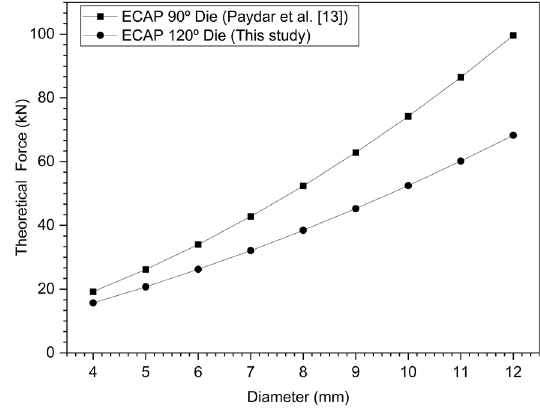
Figure 6. Theoretical pressing forces for different diameters and a fixed billet length of 30 mm for ECAP dies with intersecting angles of 90° 13 and 120°.